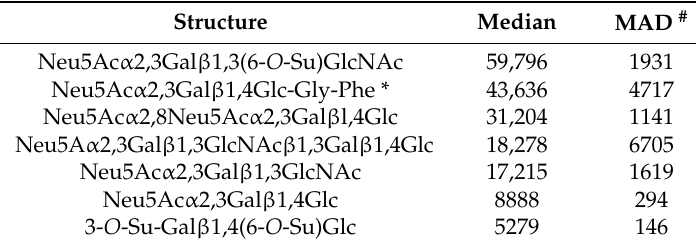
Table 1. Listing of the most active ligands of labeled Gal-8 (NN) and signal intensities. Structure